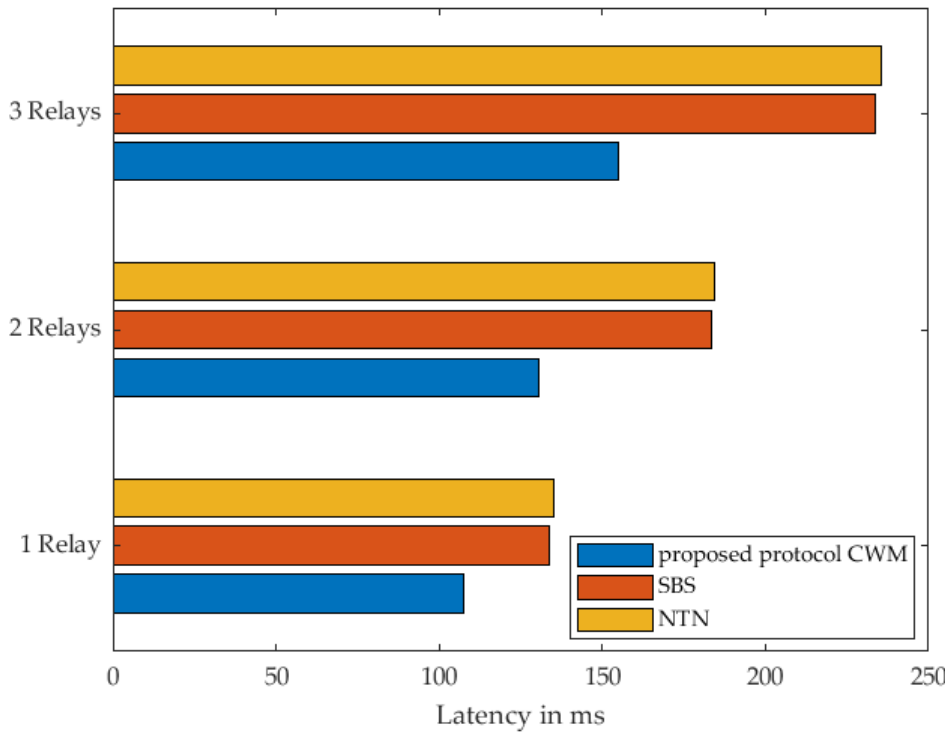
Figure 18. Routing latency with respect to the number of relay nodes comparing the 3 strategies. Table 9. Time consumption related to the number of relay nodes comparing the 3 strategies.